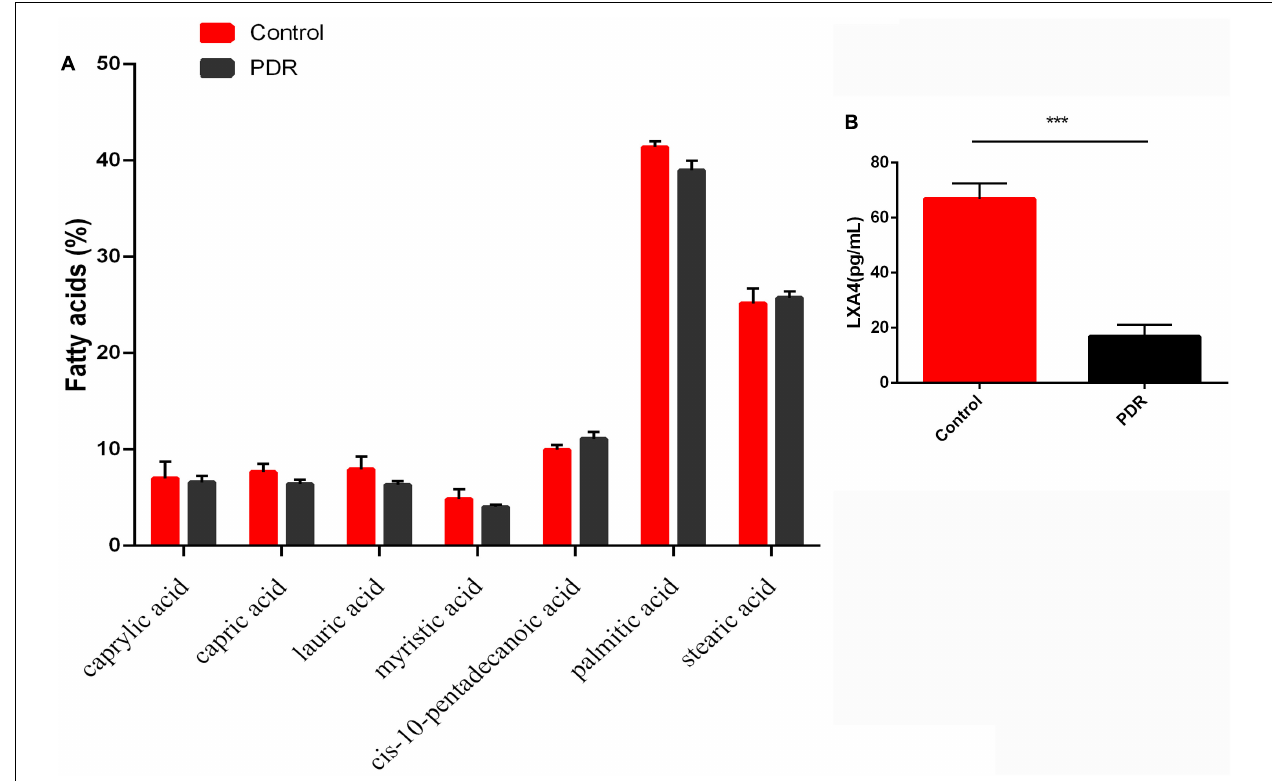
FIGURE 8 | Vitreous fatty acids profile (A) and LXA4 levels (B) in human control and human PDR groups. All values are expressed as mean ± SEM ( n = 20). Comparisons were performed using unpaired two-tailed t test. *** p ≤